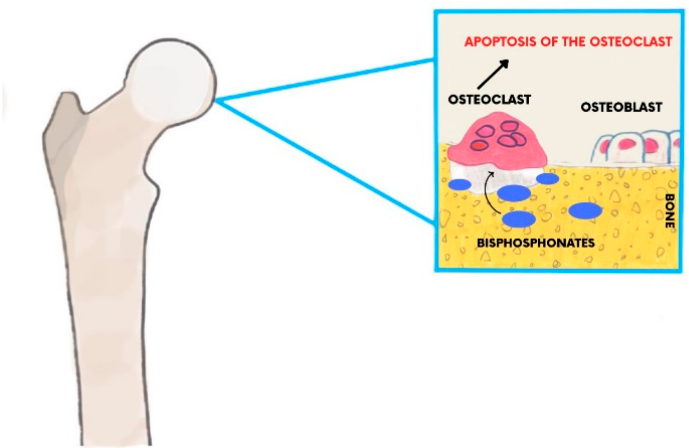
Figure 6. Mechanism of action of BPs on the bone.